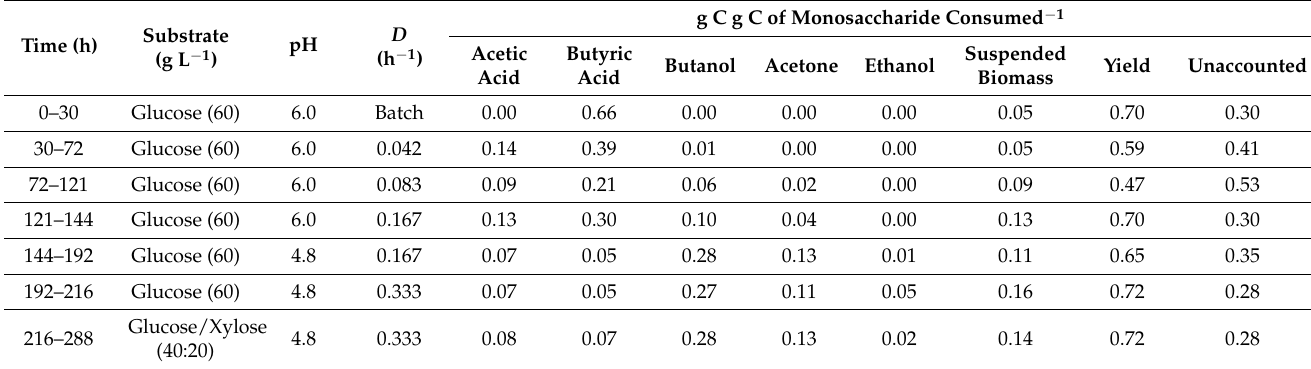
Table 3. Mass balance analysis for the continuous